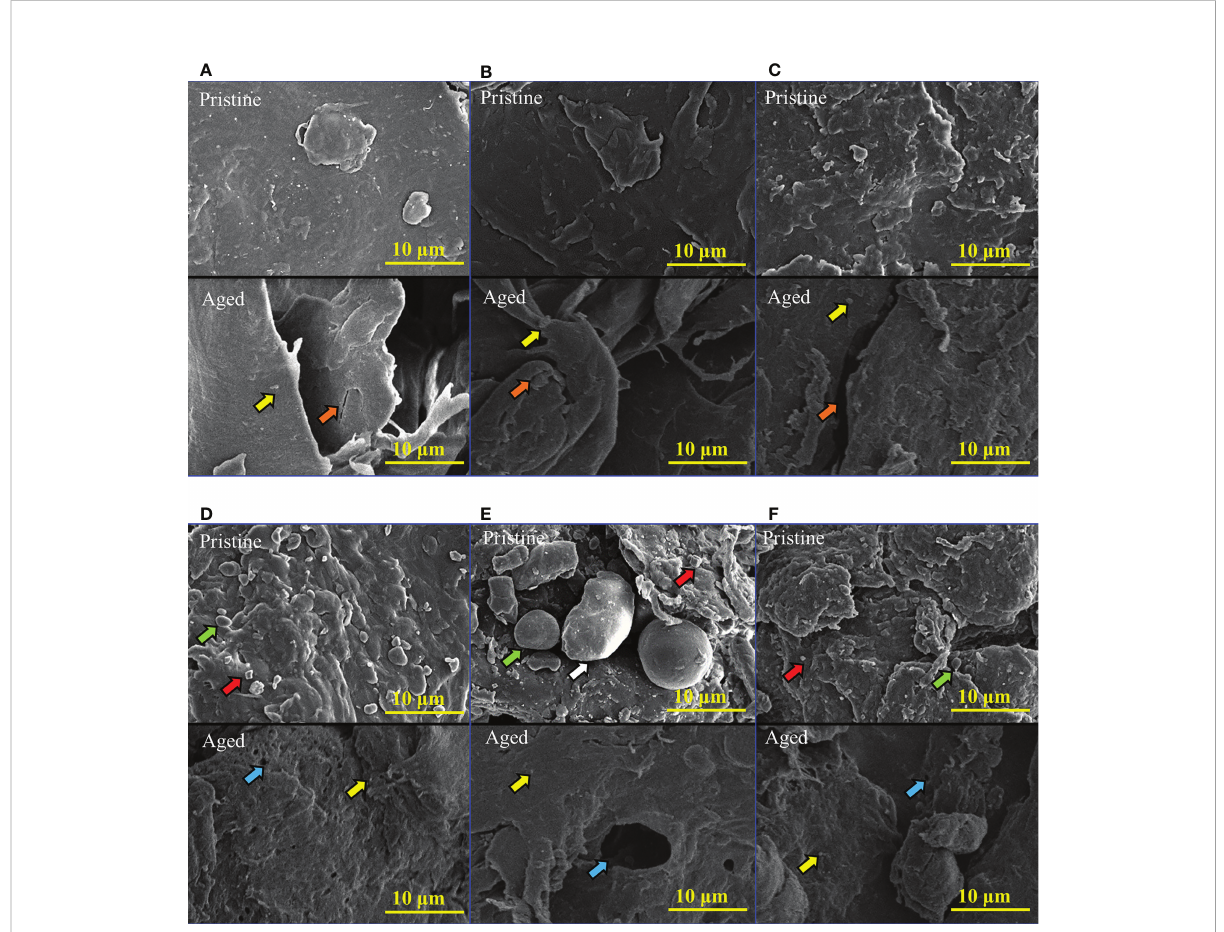
FIGURE 2 SEM images of the pristine and aged MPs treated by 2 months of UV irradiation in natural seawater. (A) PE, (B) PP, (C) PLA, (D) PE/TPS, (E) PP/ TPS, and (F) PLA/PBAT/TPS. PE, polyethylene; PP, polypropylene; PLA, polylactic acid; PE/TPS, polyethylene/thermoplastic starch blends; PP/ TPS, polypropylene/thermoplastic starch blends; and PLA/PBAT/TPS, polylactic acid/poly (butylene adipate- co -terephthalate)/thermoplastic starch blends. The red arrows indicate the formation of MP fragments on the surface of the pristine MPs. The green arrows indicate the spherical or ellipsoidal particles on the surface of the pristine MPs due to the release of starch granules. The white arrow indicates the larger starch granule. The yellow arrows indicate the smaller fragments on the surface of the aged MPs. The orange arrows indicate the formation of cracks. The blue arrows indicated the holes and pits that appeared on the surface of the aged MPs due to the migration and degradation of the starch